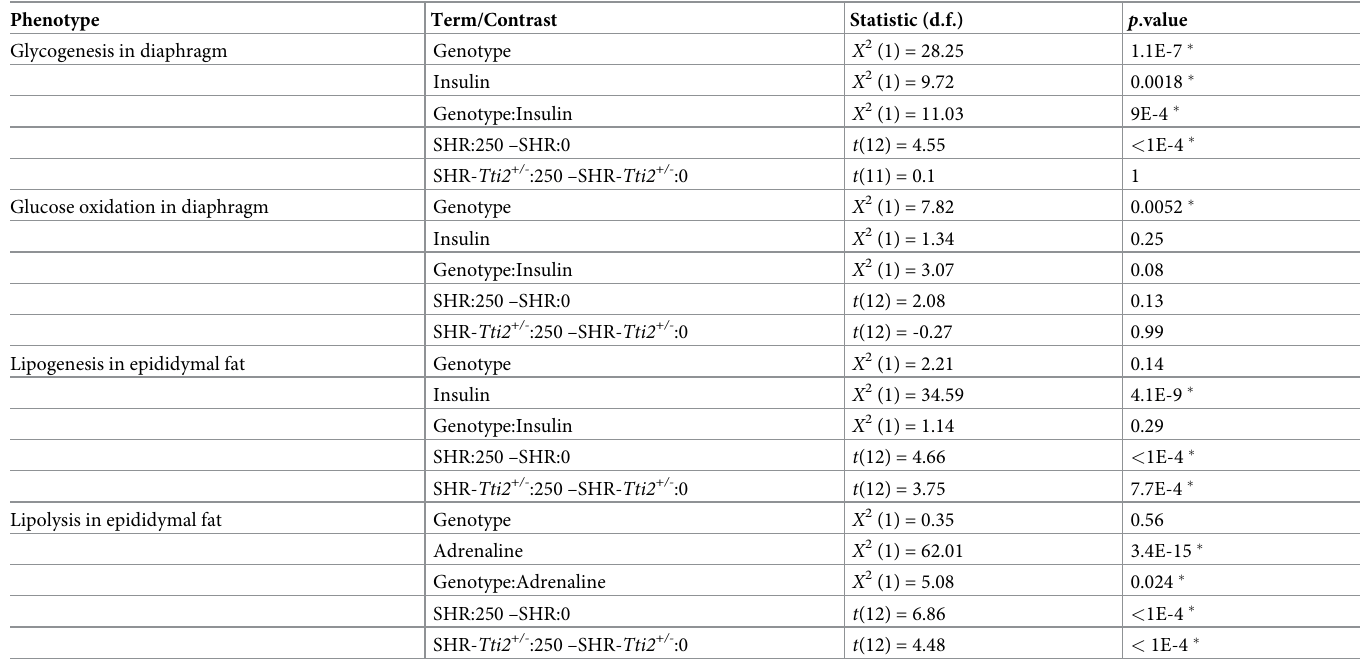
Table 3. Statistical analysis of response to insulin and adrenaline stimulation in tissues isolated from SHR- Tti2 +/- rats and SHR wild type littermates.